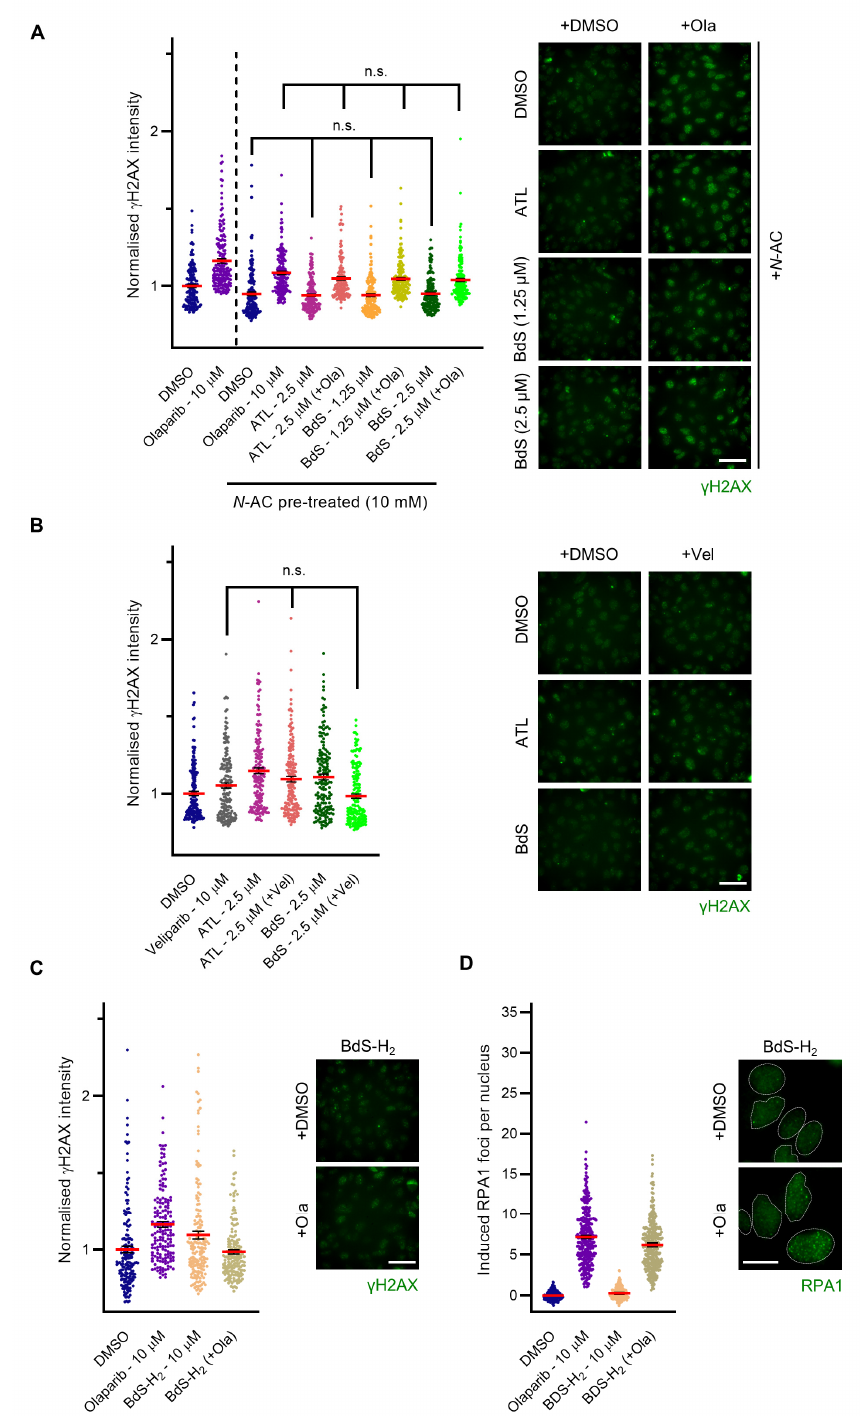
Figure 4. Cooperative effects of BdS and alantolactone (ATL) with olaparib depend on oxidative stress, PARP-trapping, and covalent binding capacity. ( A ) Quantification (left) and representative images (right) of normalised nuclear γ H2AX immunofluorescence intensity (Alexa Fluor 488) of ≥ 7500 U2OS cells (3 replicates; n = 168) following 24 h treatment with olaparib, BdS, and/or ATL as indicated, compared to vehicle only (DMSO) after N -acetylcysteine ( N -AC) pre-treatment (10 mM, 1 h). Data points relate to each recorded field (mean ± SEM). Scale bar—50 µ m. ( B ) Quantification (left) and representative images (right) of normalised nuclear γ H2AX immunofluorescence intensity (Alexa Fluor 488) of ≥ 7500 U2OS cells (3 replicates; n = 168) following 24 h treatment with veliparib, BdS, and/or ATL as indicated, compared to vehicle only (DMSO). Data points relate to each recorded field (mean ± SEM). Scale bar—50 μ m. ( C ) Quantification (left) and representative